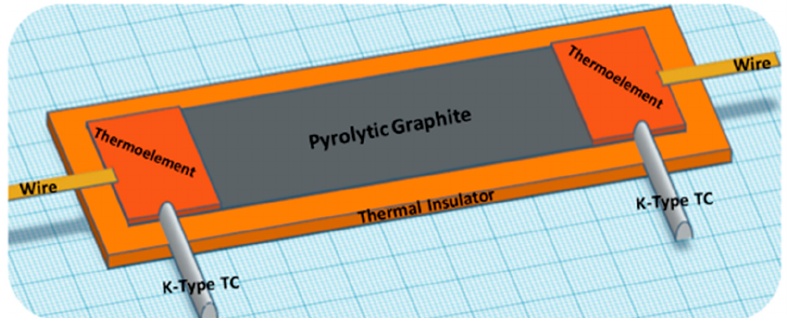
Figure 2. Sectional drawing of the thermocouple type used.